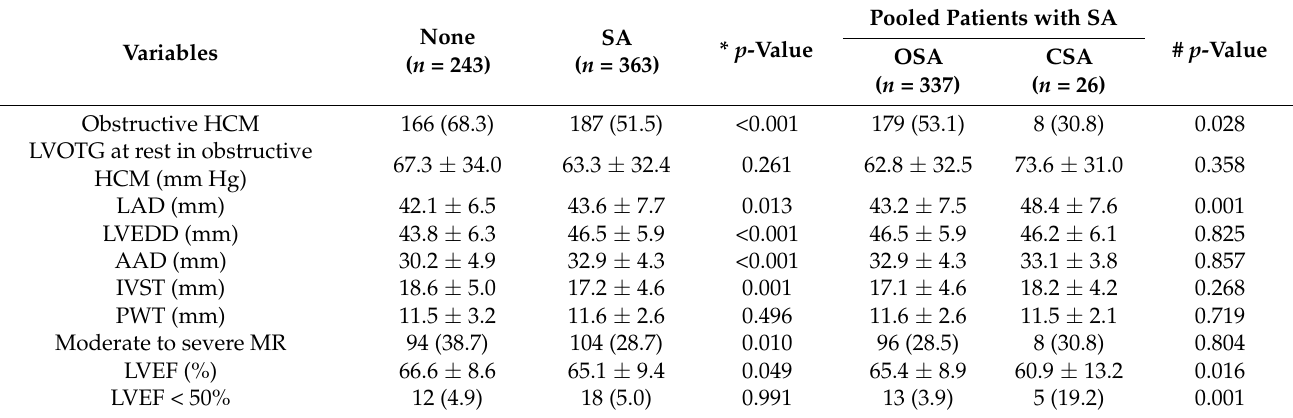
Table 2. Echocardiographic data of HCM patients grouped according to types of sleep apnea.